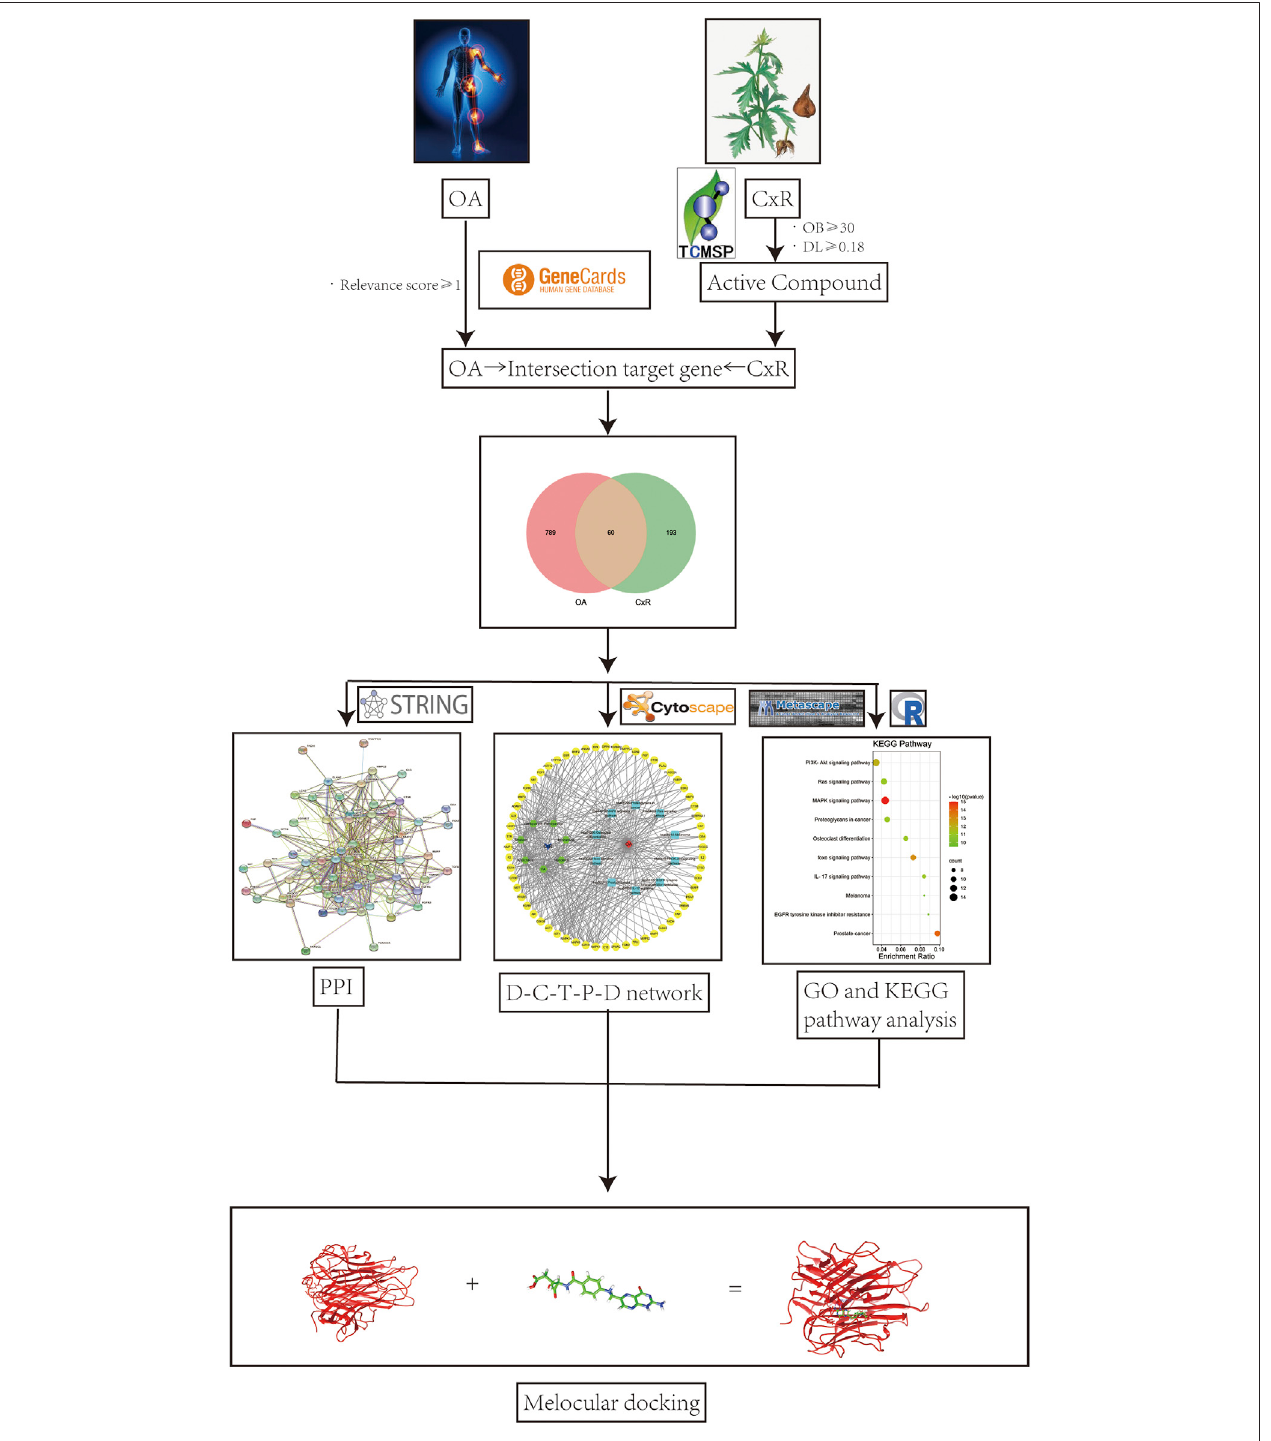
FIGURE 1 | Flow chart of network pharmacology to study the potential molecular mechanism of CX in the treatment of OA.